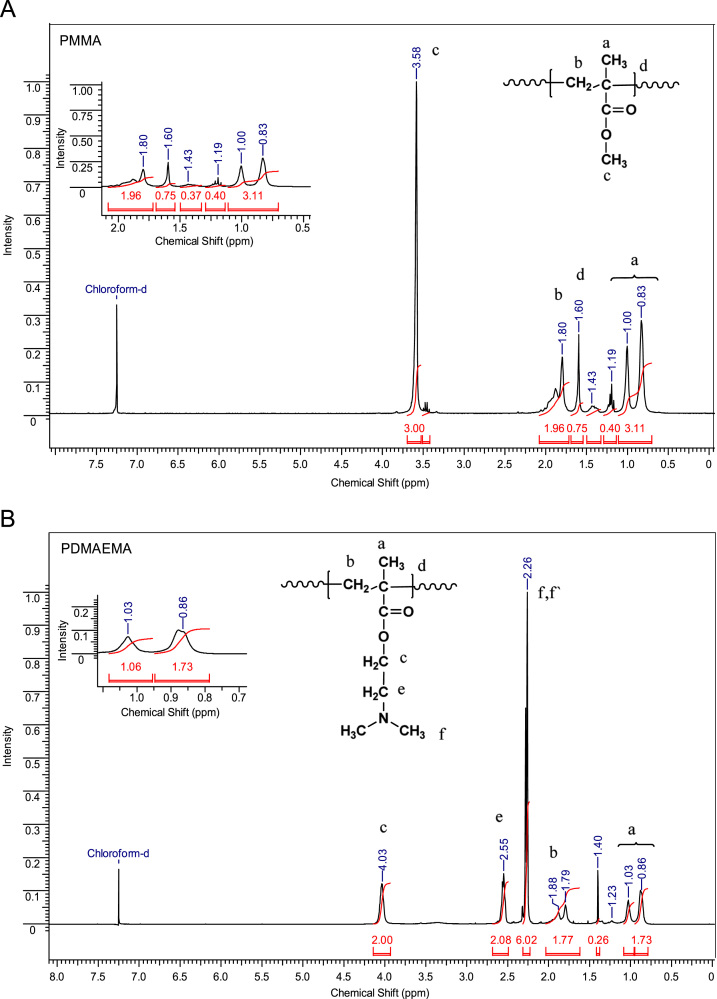
1H NMR (CDCl3, 300 MHz) spectra of PMMA (A) and PDMAEMA (B).